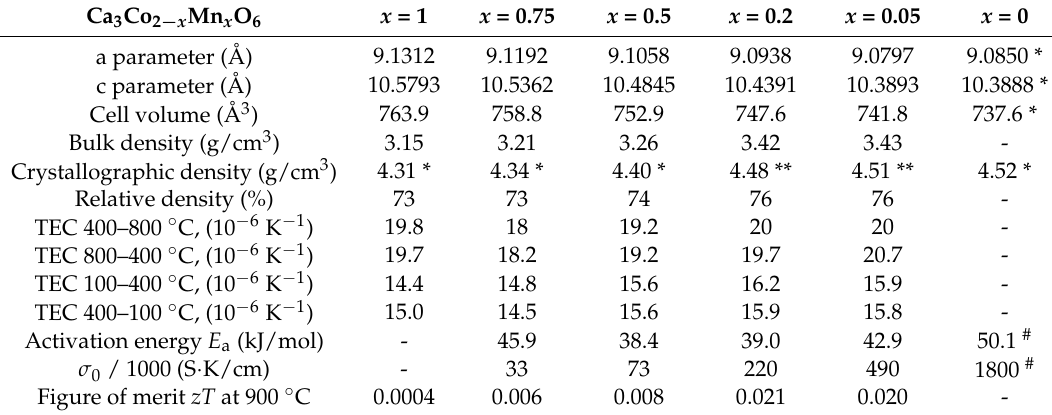
Figure of merit zT at 900 ◦ C 0.0004 0.006 0.008 0.021 0.020 - * Calculated from data by Hervoches et al. [11] and # by Mikami et al. [12]. ** Interpolated